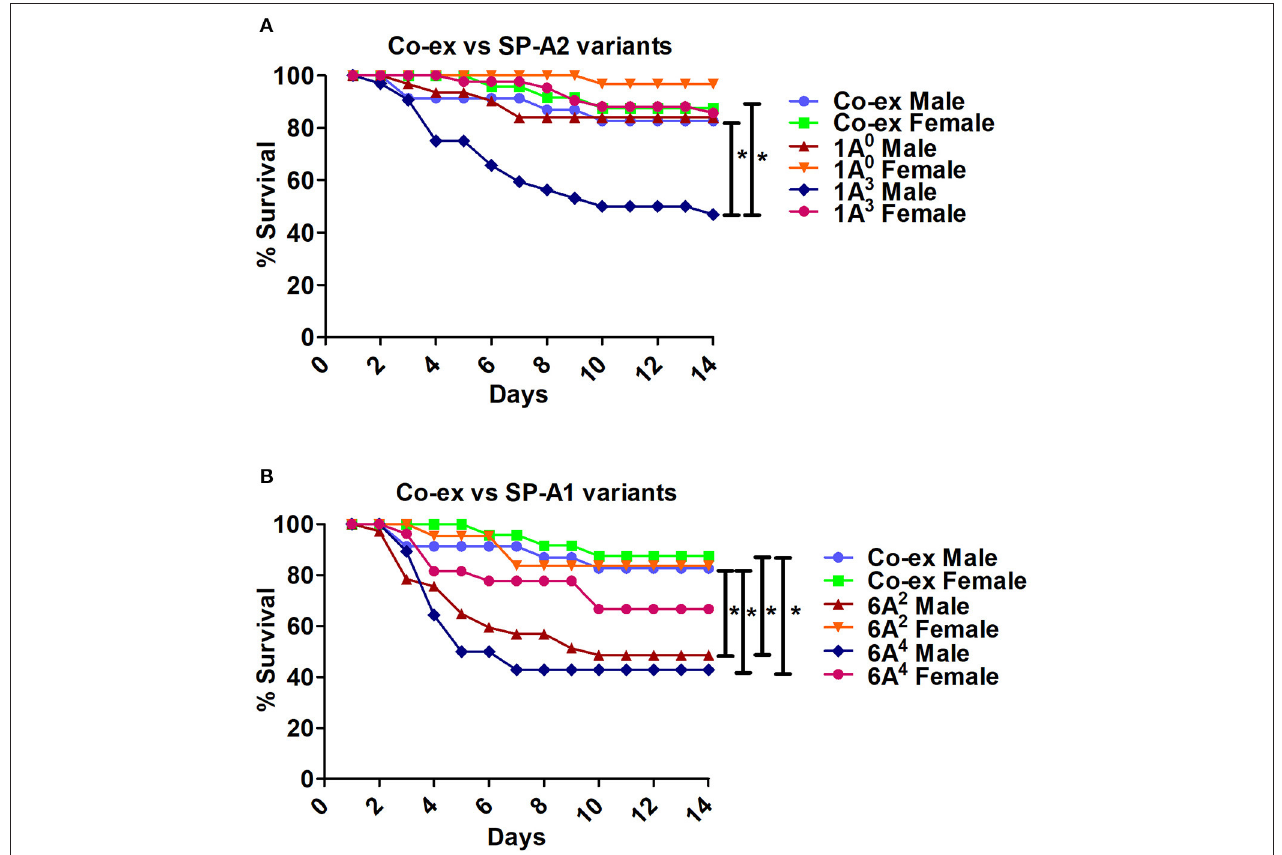
FIGURE 5 | Comparison of survival between co-ex and single gene SP-A variants after K. pneumoniae infection . (A) Depicts differences in survival between males and females of co-ex vs. SP-A2 (1A 0 , 1A 3 ) and (B) depicts differences of co-ex vs. SP-A1 (6A 2 , 6A 4 ). Mouse survival was monitored for 14 days after infection. Significant differences for survival are indicated * p < 0.05. The number of mice used for each group is shown in Figure 2 .